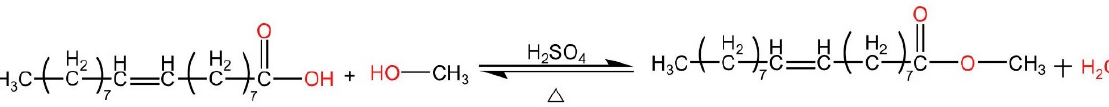
Figure 1. Equation for the esterification of oleic acid with methanol.